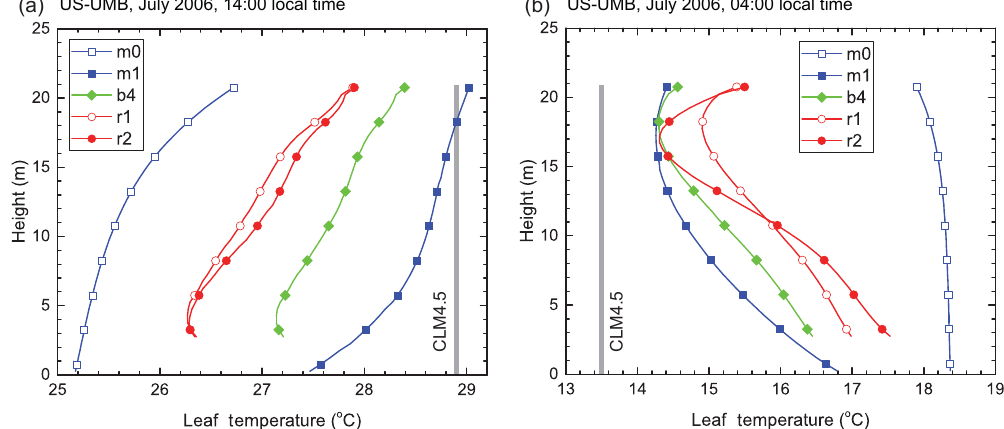
Figure 11. Profiles of leaf temperature for US-UMB averaged for the month of July 2006 at 14:00 local time (a) and 04:00 local time (b) . Temperature is averaged for sunlit and shaded leaves at each level in the canopy. Shown are the m0, m1, b4 (ML–RSL), r1, and r2 (ML + RSL) simulations. The CLM4.5 canopy temperature is shown as a thick gray line, but is not vertically